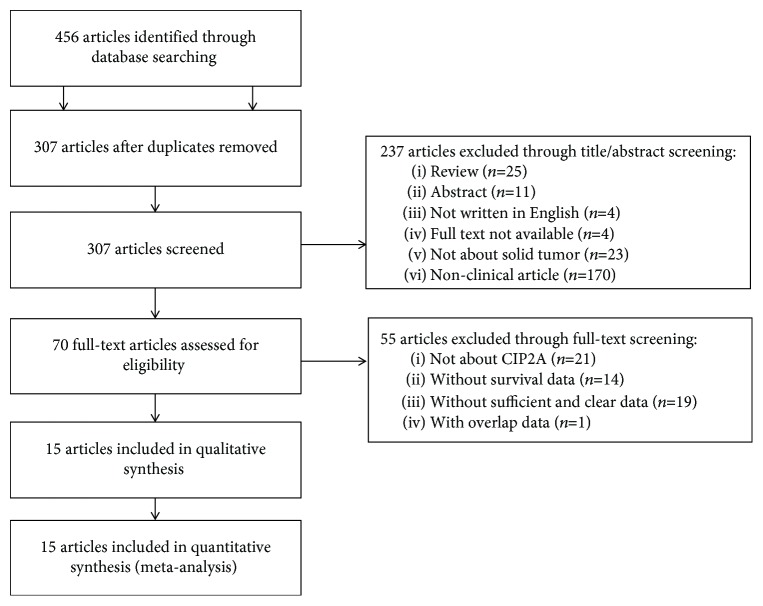
Flow chart of study selection.